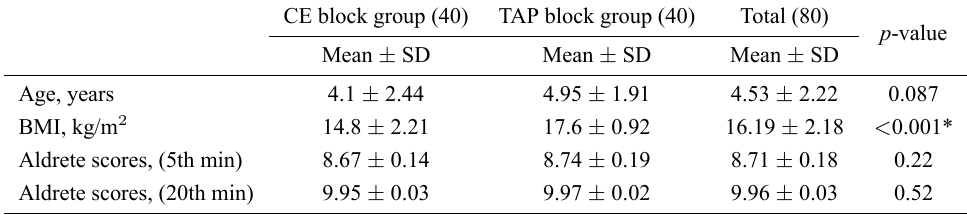
Table 1. Assessment of age, BMI and Aldrete scores between groups.